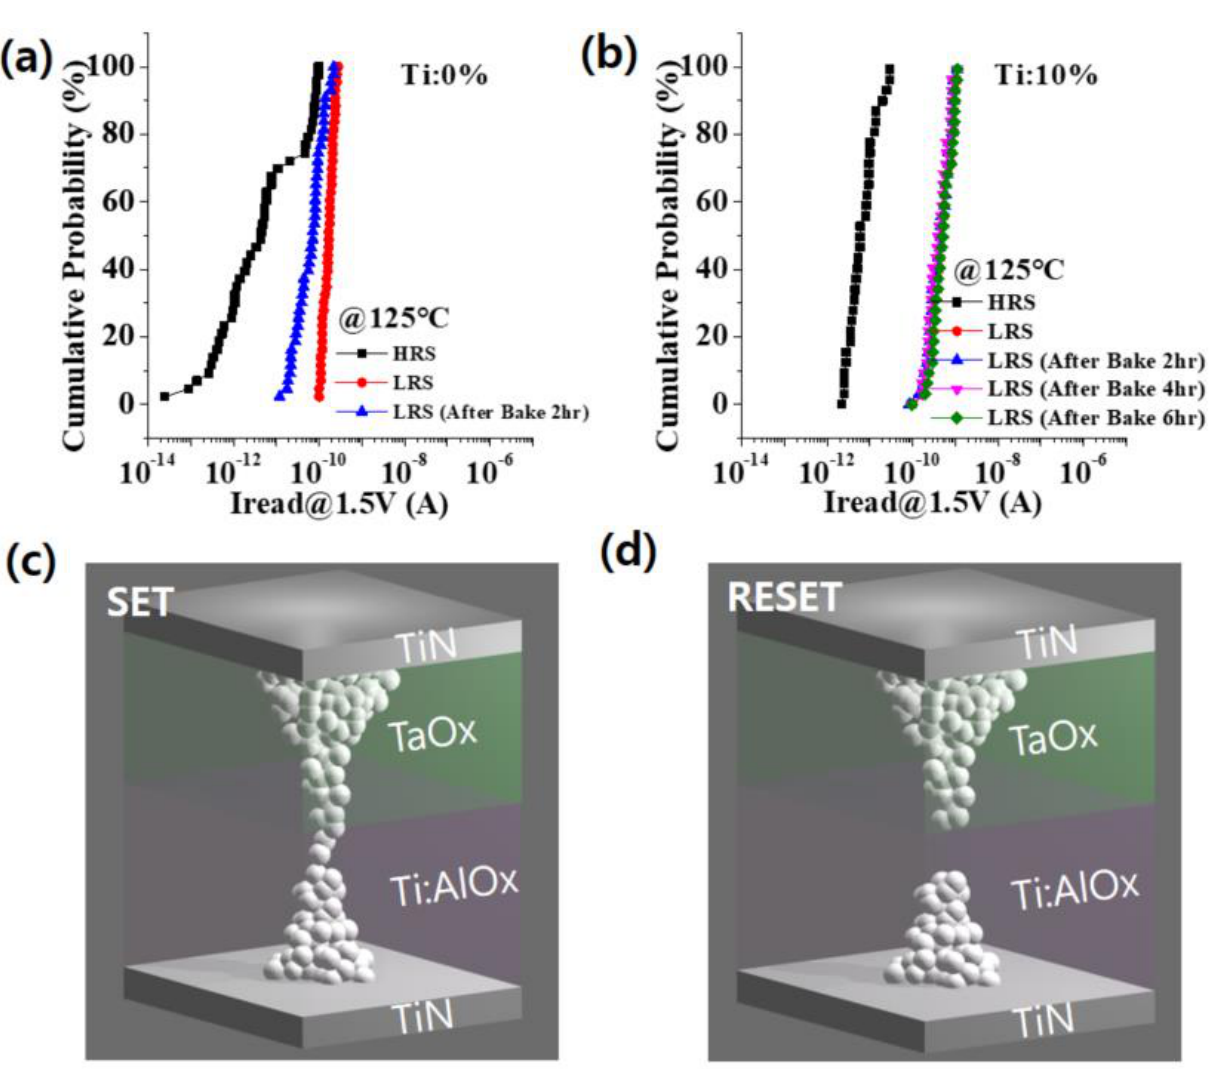
Figure 3. ( a , b ) show the retention characteristics of the Ti 0% and 10% RRAM devices, respectively. The schematic figures for a sequential RS cycle. ( c , d ) show the LRS the HRS of the RRAM device, respectively.